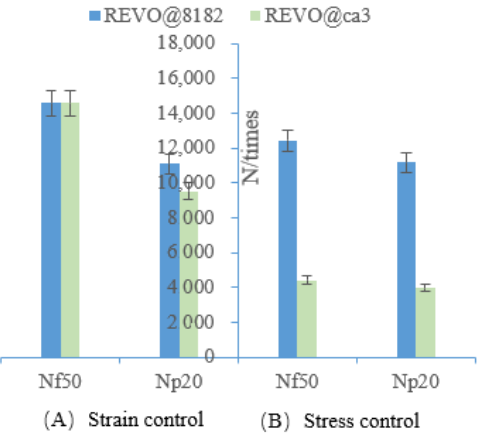
Figure 6. Evaluation results of N f50 and N p20. under stress (100 kpa)/strain (4.5%) mode. Through the preceding analysis, the following conclusions can be found.